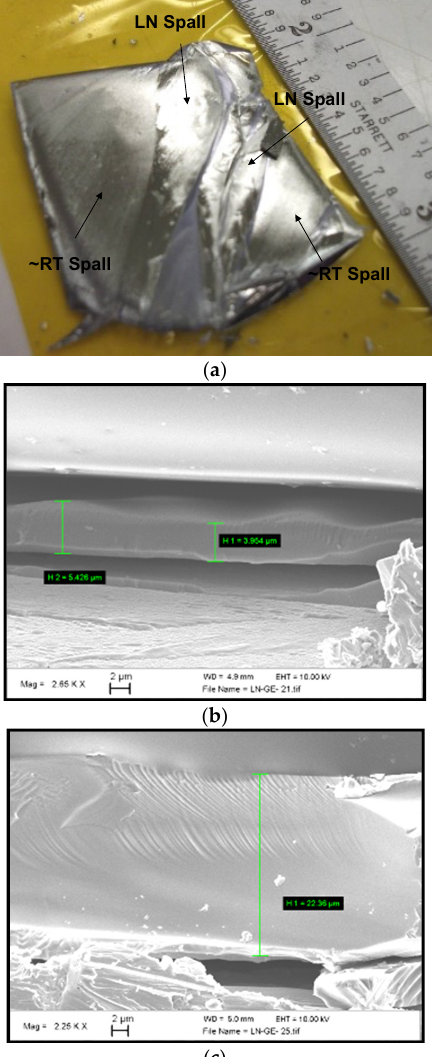
Figure 7. ( a ) Optical image of Si(100) spalled at 300 K and at 77 K in different areas of the same piece of wafer. ( b ) SEM micrograph of the side view of Si(100) spalled at 300 K. The variation in spalled layer thickness, as shown by green lines, is between 3.91 to 5.43 µm. ( c ) Side view SEM micrograph of Si(100) spalled at 77 K, where the thickness of the spalled film is almost constant at around 22.38 µm.